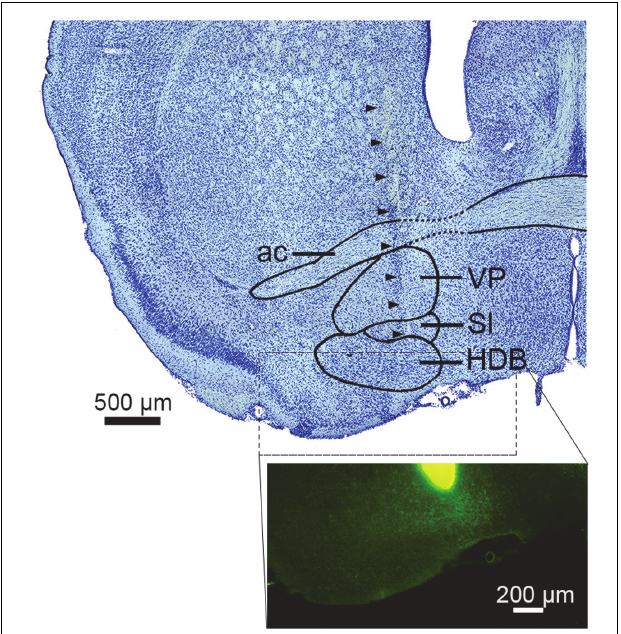
FIGURE 1 | Electrode track in the basal forebrain. (top) Nissl-stained section showing the sub-nuclei of the basal forebrain (BF). Arrowheads indicate the track of a silicon probe. ac, anterior commissure; VP, ventral pallidum; SI, substantia innominate; HDB, nucleus of the horizontal limb of the diagonal band. (bottom) The tip of a silicon probe was located within the BF (HDB or SI) based on DiI staining. Green signals indicate ChR2-EYFP.